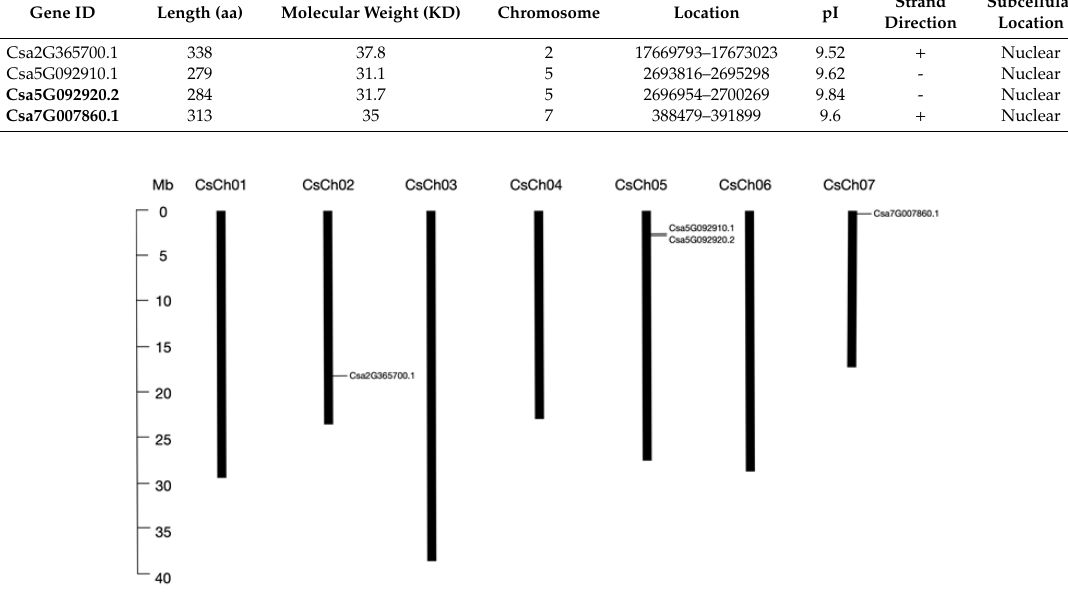
Figure 1. Localization of four cucumber BPC genes on chromosomes. There are seven chromosomes in cucumber, and the chromosome number is indicated at the top of each chromosome. The scale bar on the left side indicates the size of chromosome. The relative positions of four BPC genes are marked on the chromosomes.